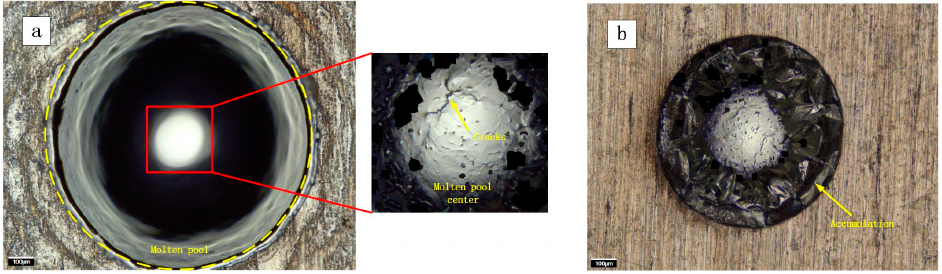
Figure 3. The ablation morphology under different spot size combination modes. ( a ) the ns spot is larger ( b ) the ms spot is larger.